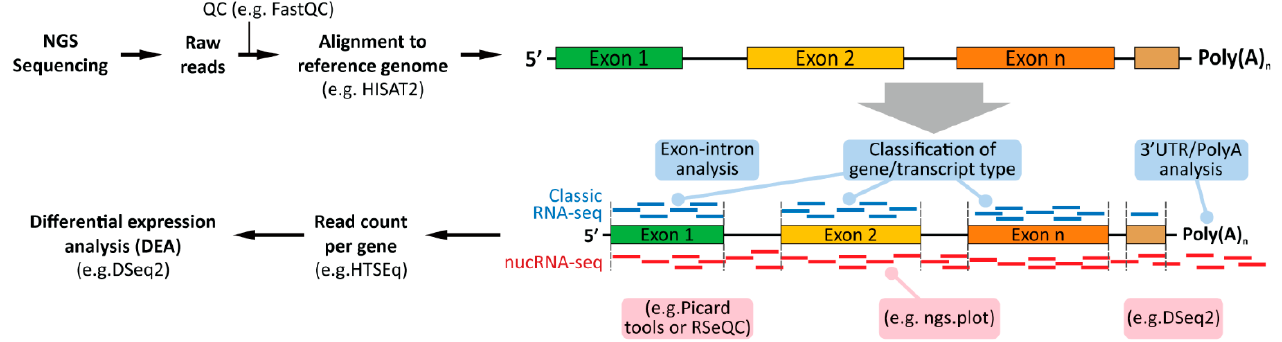
Figure 3. Overview of data analysis of classic and nuclear RNA-seq. Notably, all the mentioned tools can be applied both on nucRNA-seq and classic